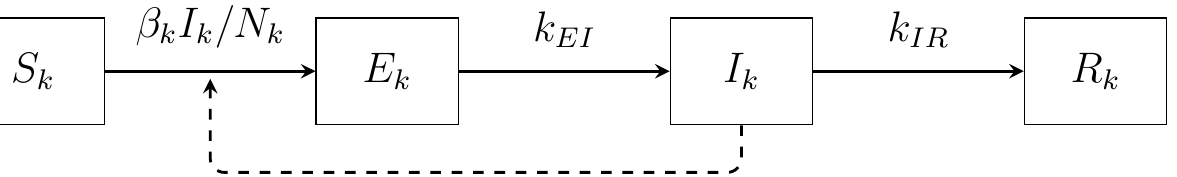
Figure 1. Structure of the SEIR model describing a single country. Susceptible individuals ( S k ) are exposed ( E k ) to the virus at a rate β k I k / N k . They become infectious ( I k ) at a rate k EI and recover/are removed ( R k ) at a rate k IR